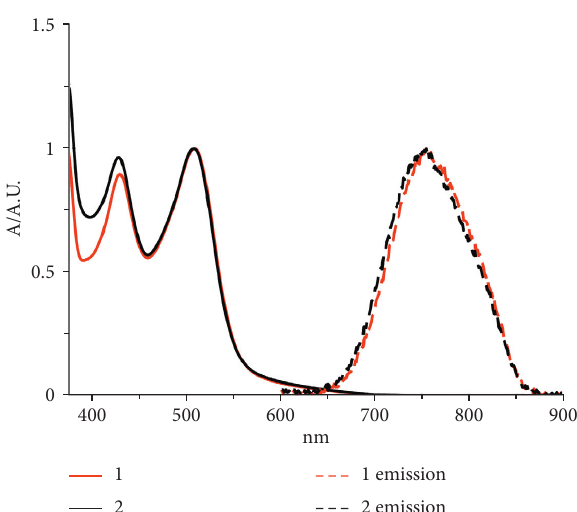
Scheme 2: Preparation routes for complexes 1 and 2.